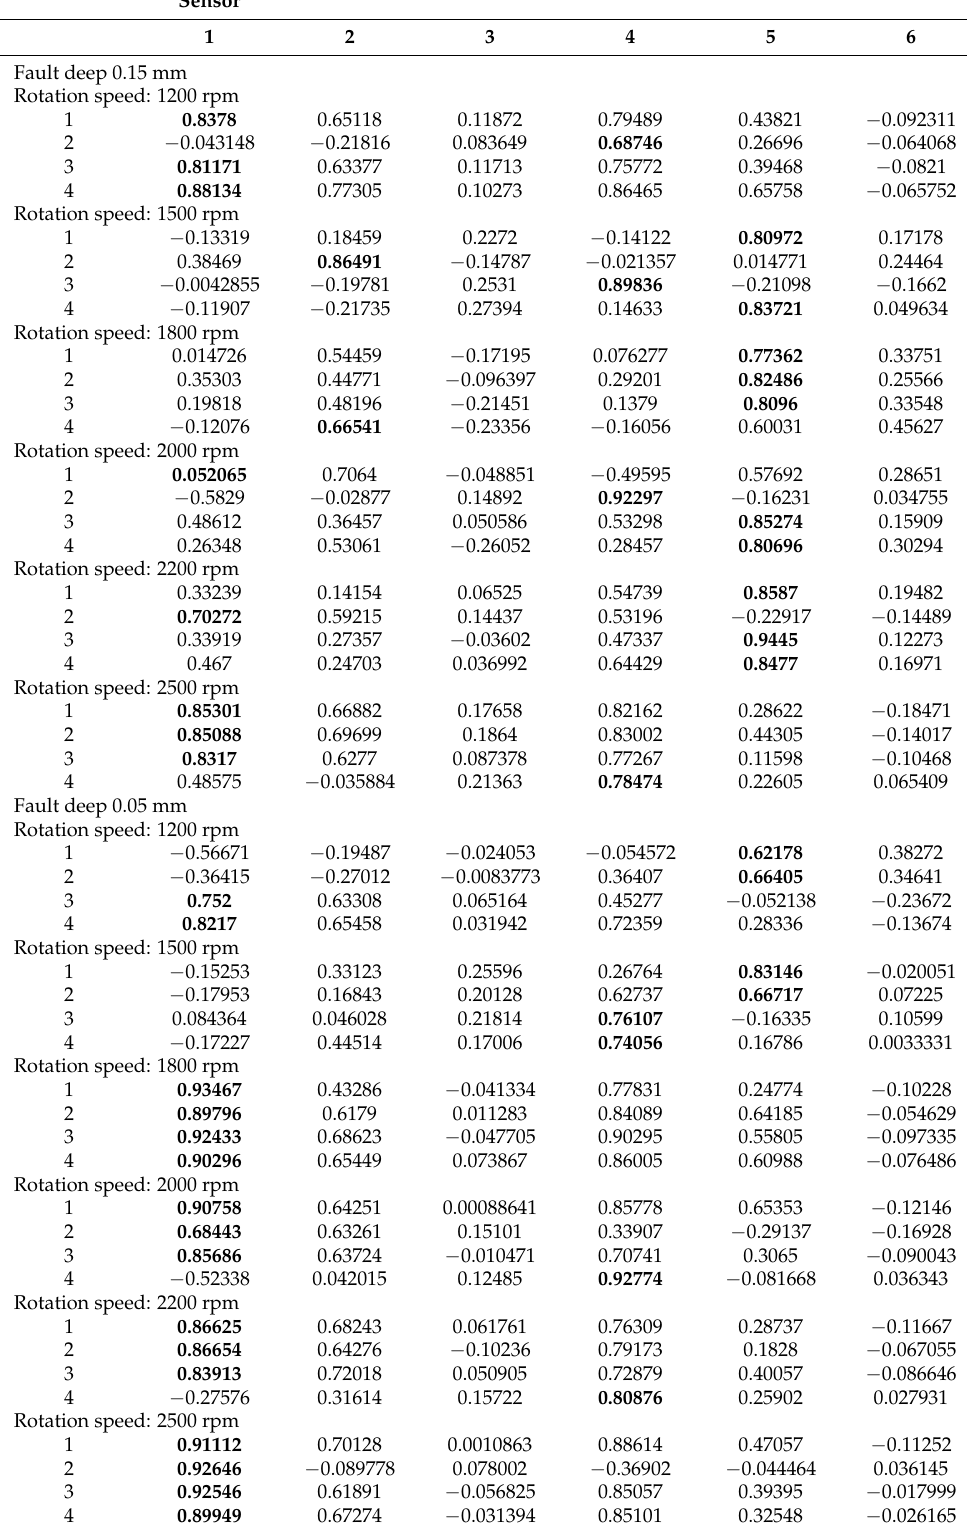
Table 3. Data managements about correlation coefficients for signal contrast (Outer race